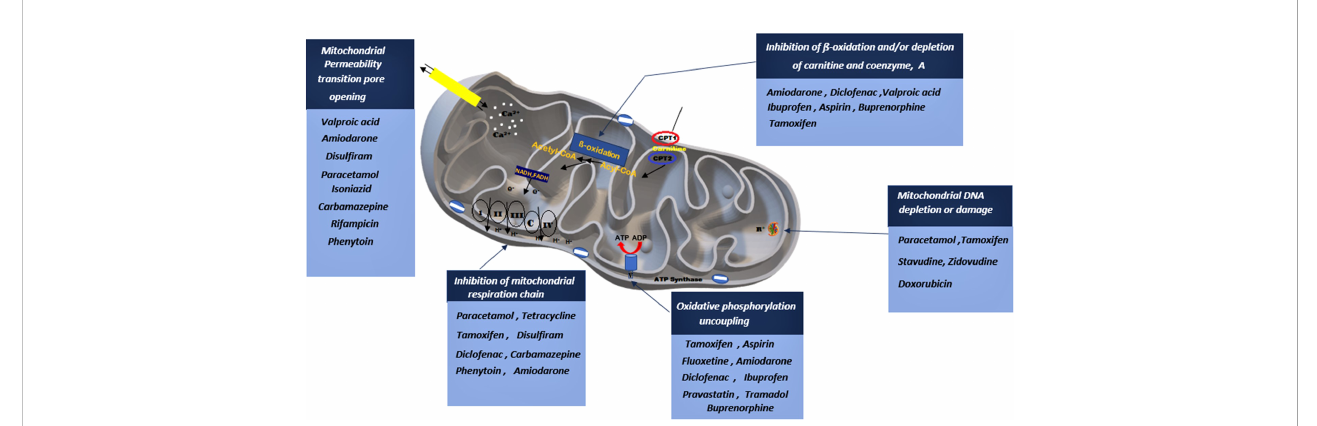
FIGURE 3 A depiction on how various drug classes can potentially lead to mitochondrial impairment through interfering with various mitochondrial sites. Drugs can stimulate the opening of the mitochondrial permeability pore, inhibit the mitochondrial respiratory chain, stimulate phosphorylation uncoupling, block b -oxidation and induced mitochondrial DNA